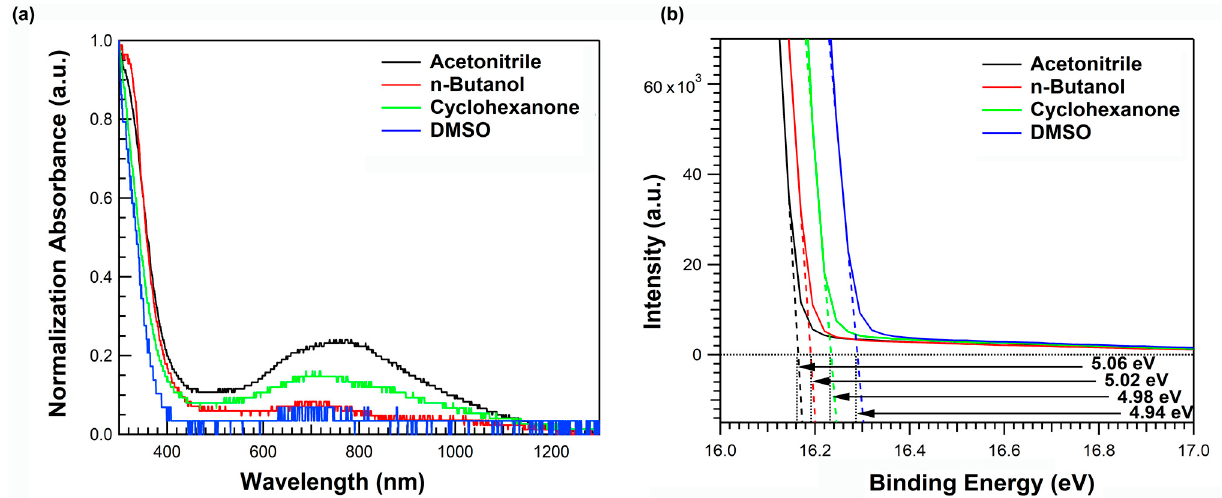
Figure 1. Thin-film characteristics of PMA with various solvents: ( a ) UV–Vis–NIR absorbance spectrum, ( b ) Cut-off region fitting graph of UPS measurement.